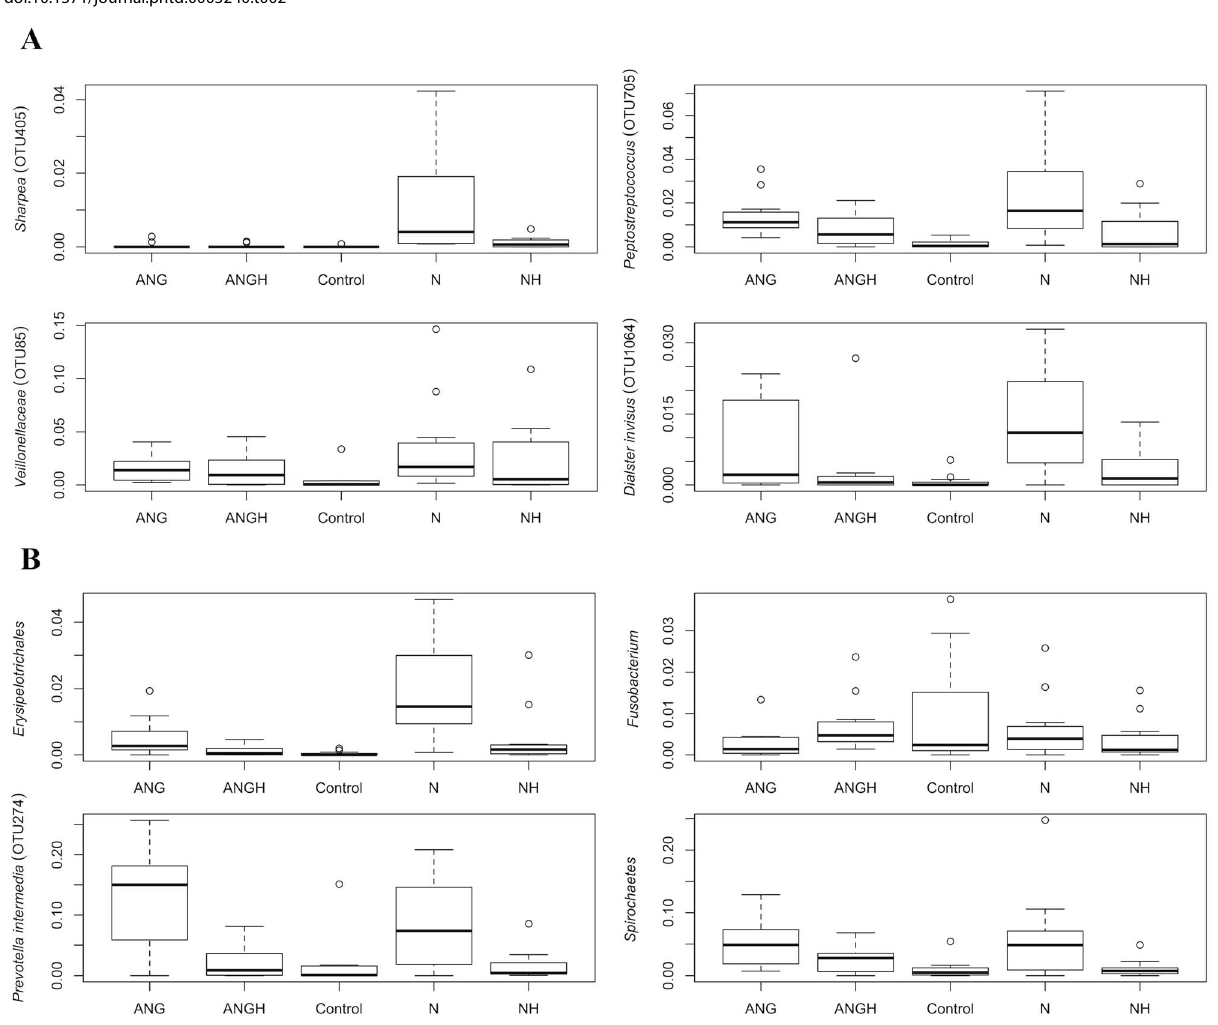
Figure 4. Box plots of abundances (proportion of total reads) for several bacterial taxa of interest. (A) The relative abundance of the top 4 97% OTUs that indicate the noma lesion samples are shown across the sample types (B) The relative abundances of several taxonomic groups of interest.